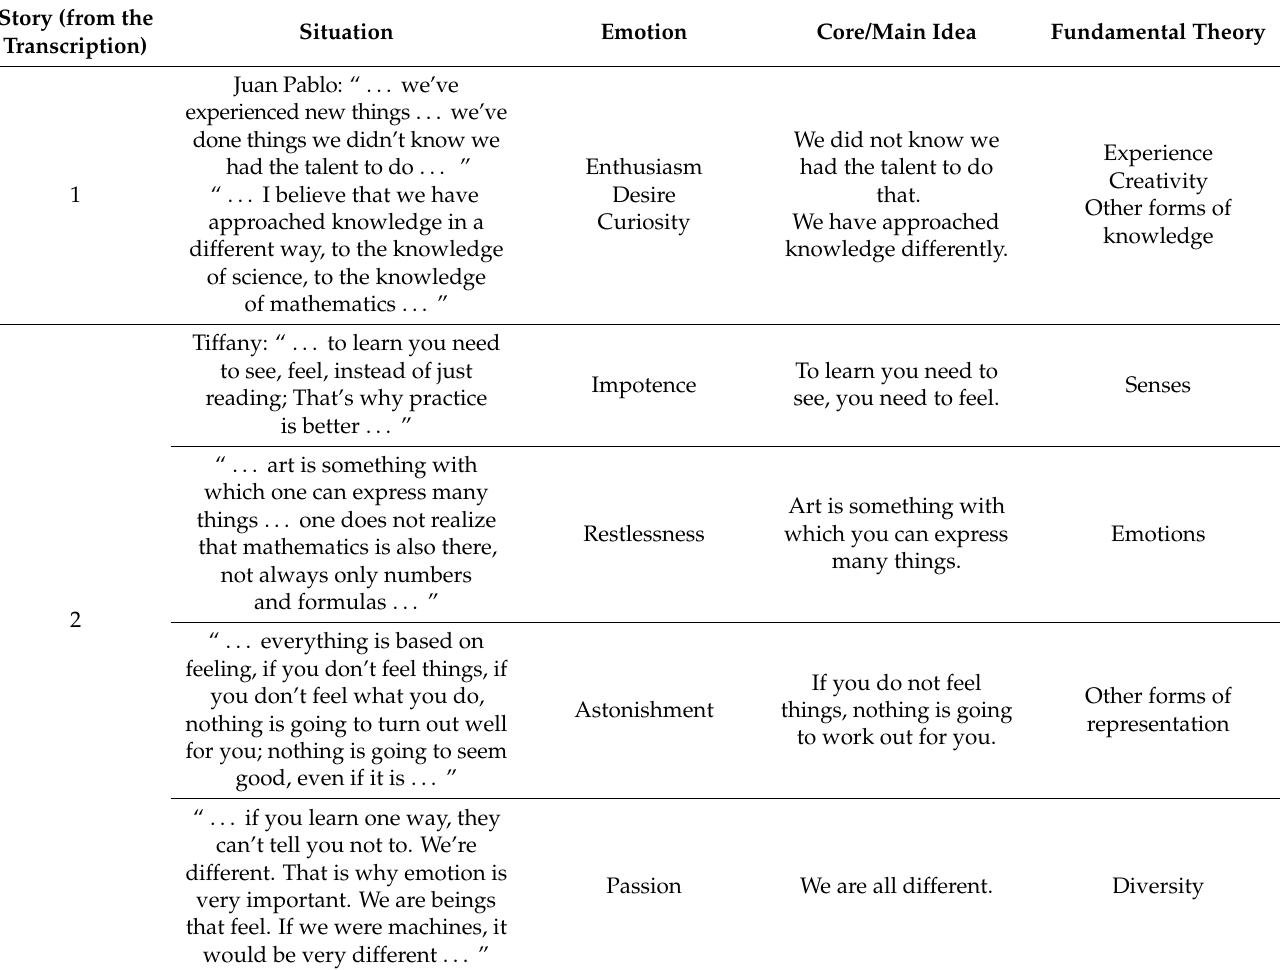
Table 1. Categorical matrix decoding the information obtained from the experiences of the students. Story (from the Situation Emotion Core/Main Idea Fundamental Transcription)